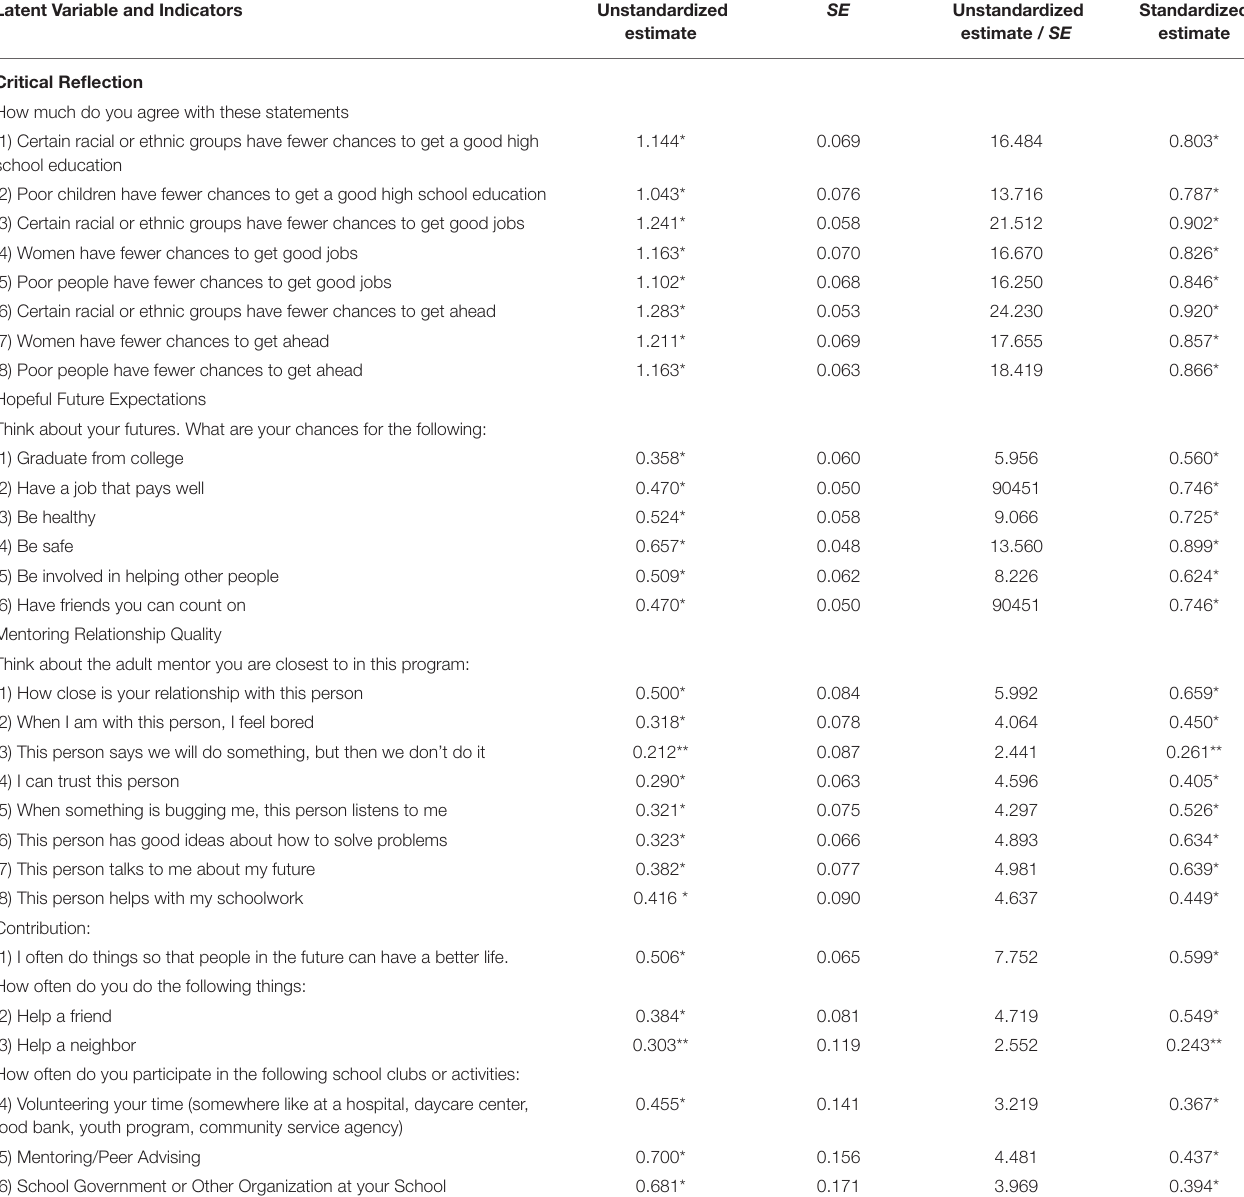
TABLE 1 | Measurement model: Factor loadings for latent variables. Latent Variable and